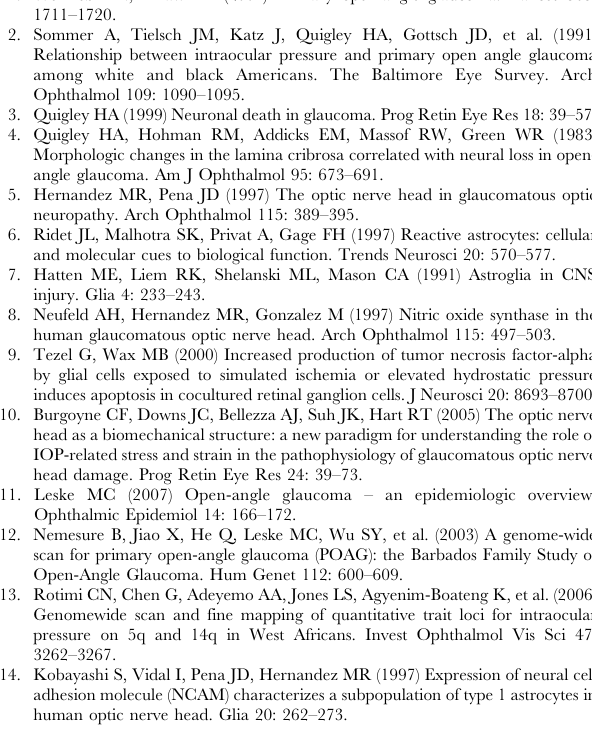
Table S2 Genes differentially expressed in ONH astrocytes from normal AA donors compared to their caucasian counterpart using RMA SAM. List of genes differentially expressed in AA ONH astrocytes compared to CA ONH astrocytes, obtained by RMA- SAM analysis. Table S3 Genes differentially expressed in normal AA ONH astrocytes compared to their CA counterpart using Lima. List of genes differentially expressed in AA ONH astrocytes compared to CA ONH astrocytes, obtained by using Limma package in Bioconductor.